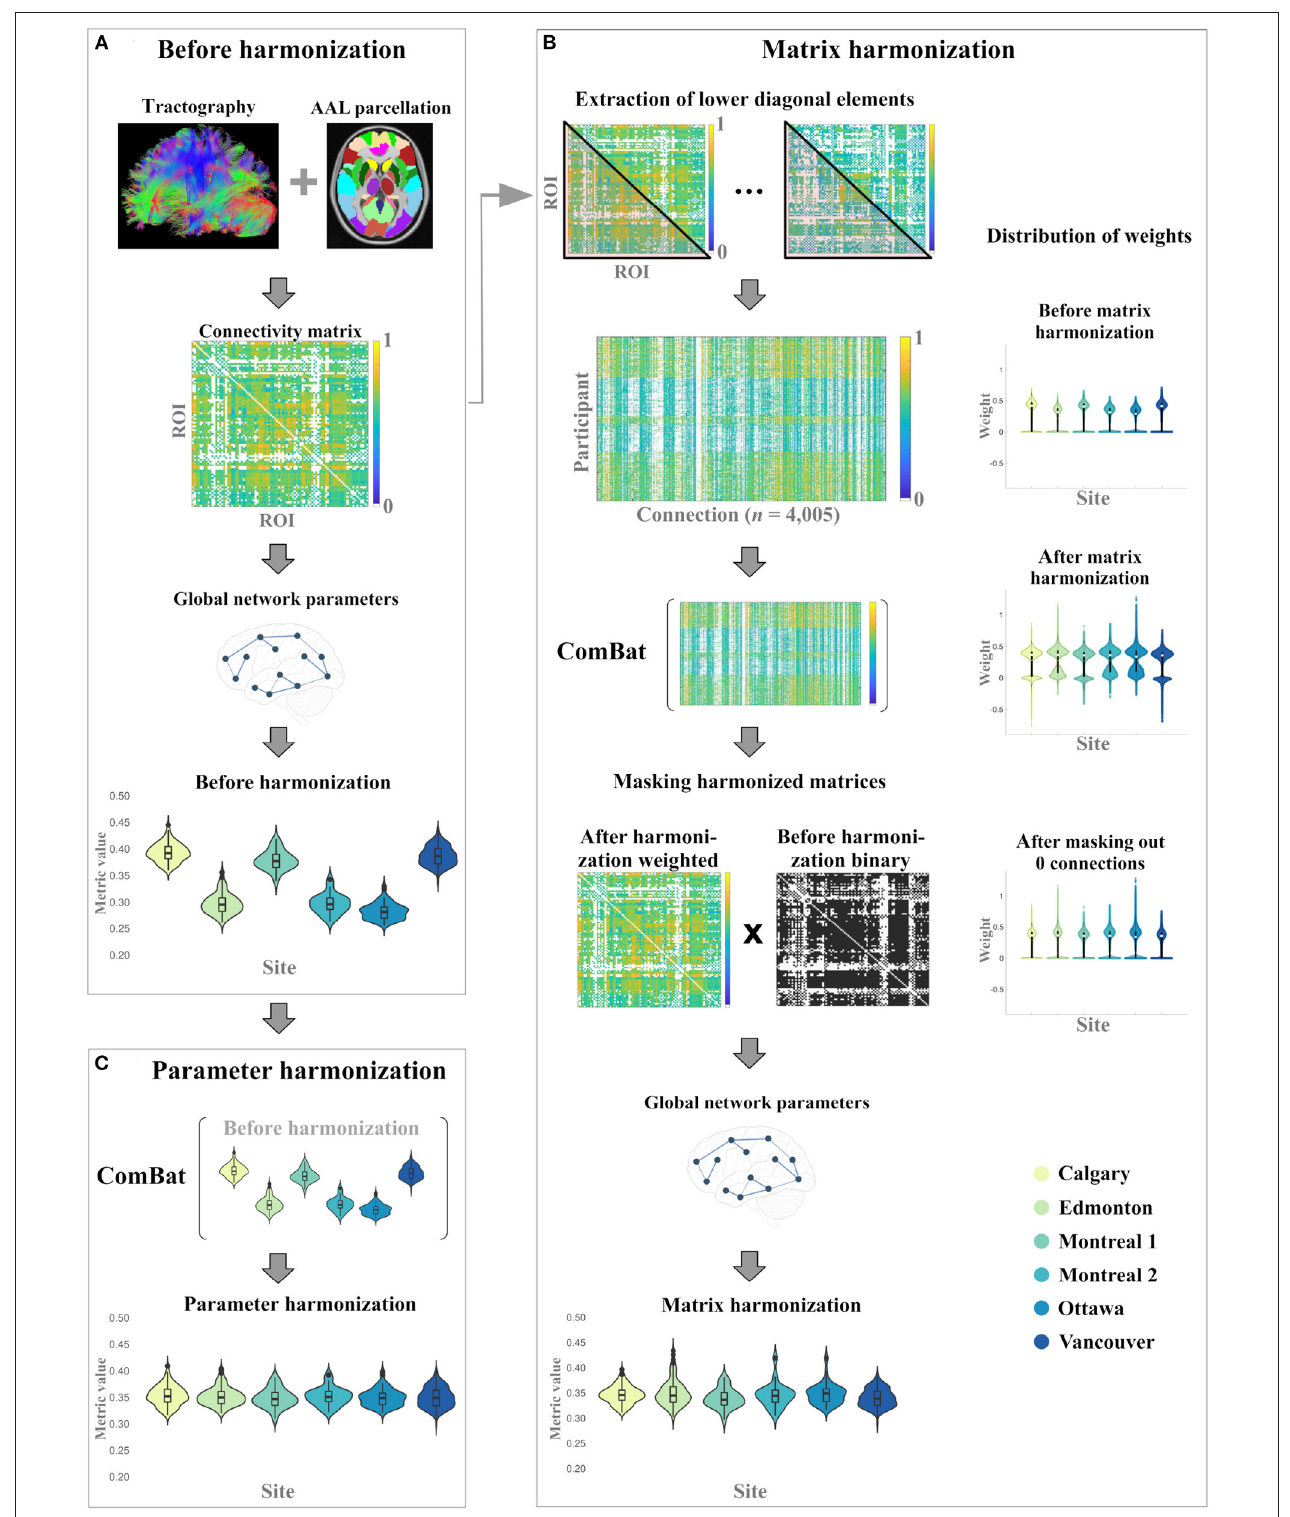
FIGURE 1 | Overall study procedure illustrating the data processing steps for the generation global network parameters (A) before harmonization, and the implementation of (B) matrix harmonization, and (C) parameter harmonization.